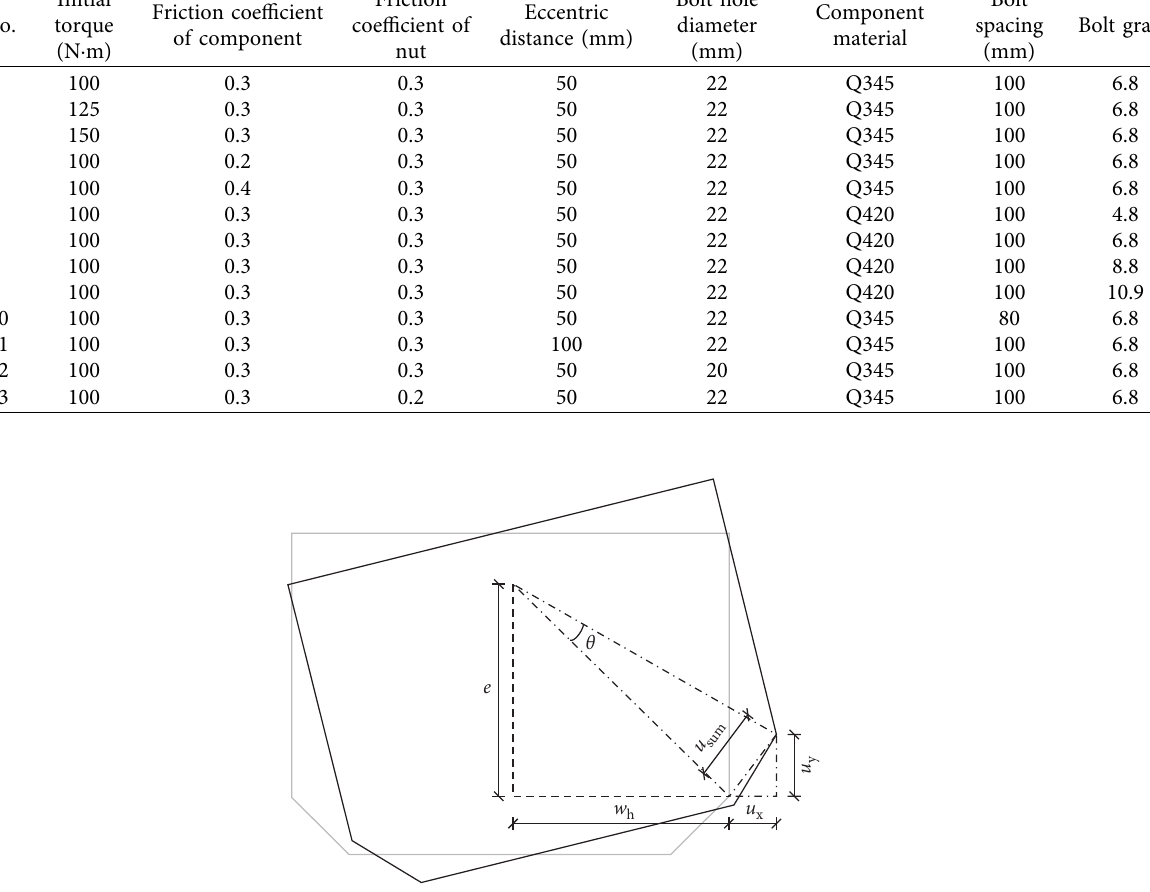
Figure 3: Diagram of rotation